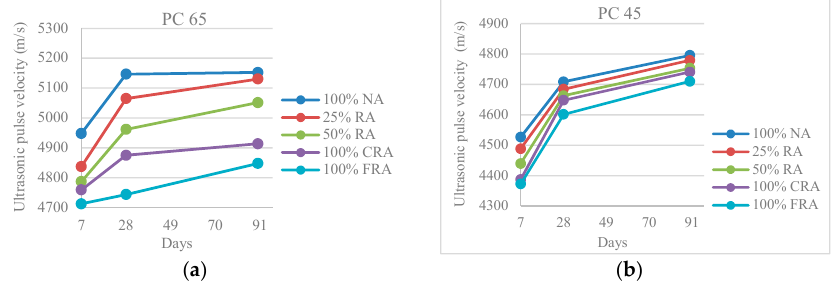
Figure 8. ( a ) Ultrasonic pulse velocity at 7, 28 and 91 days (PC 65); ( b ) Ultrasonic pulse velocity at 7, 28 and 91 days (PC 45).